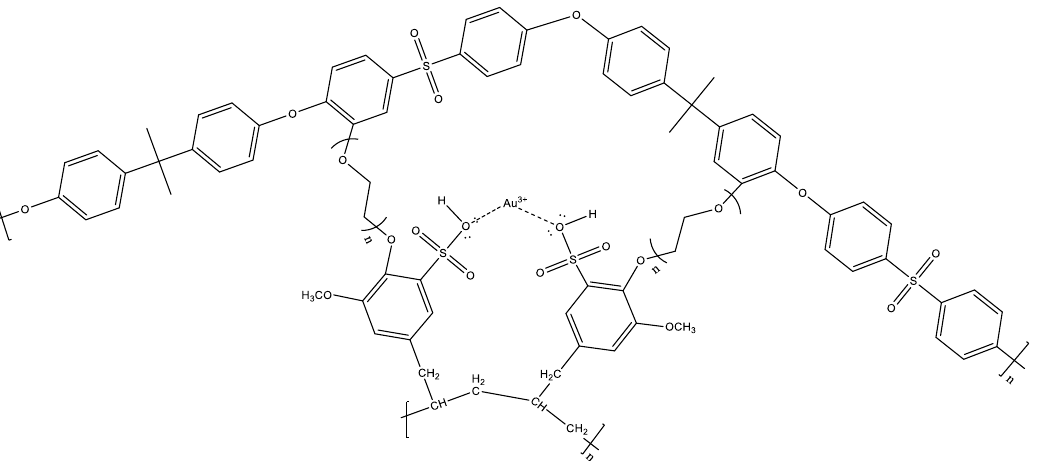
Figure 5. Estimation of crosslink bond in IIM-Au(III).